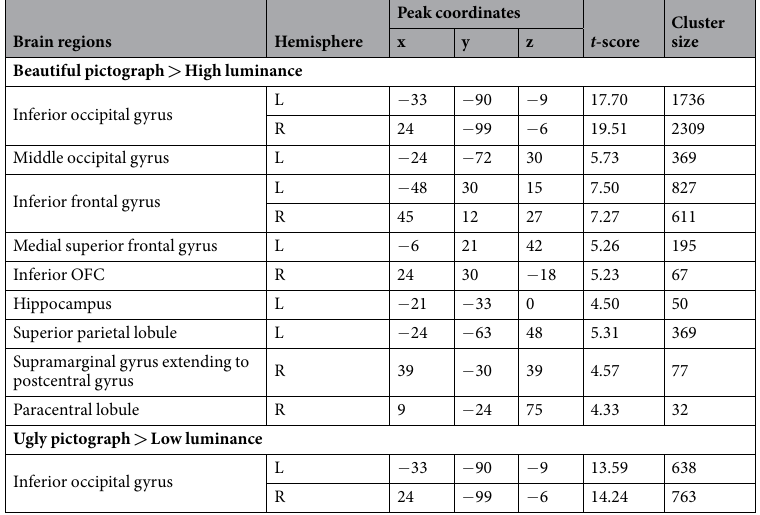
Table 1. Activated areas correlating with the aesthetic judgments of pictographs. Note: Coordinates refer to the stereotactic space of the Montreal Neurological Institute. The statistical significance refers to p < 0.001 at voxel level (uncorrected), p < 0.05 at cluster level (FWE corrected).